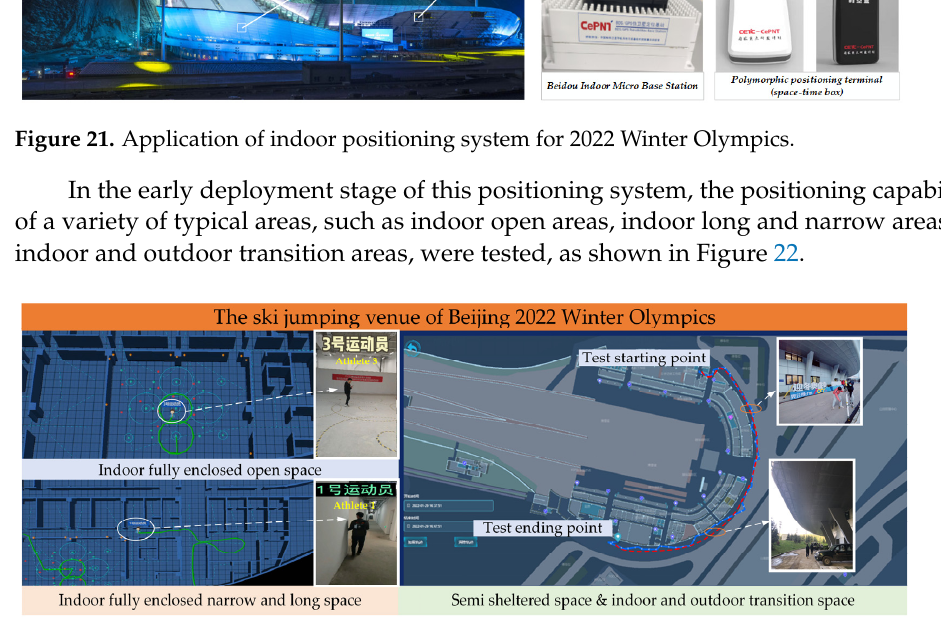
Figure 22. Localization results of multiple typical indoor and outdoor scenes.